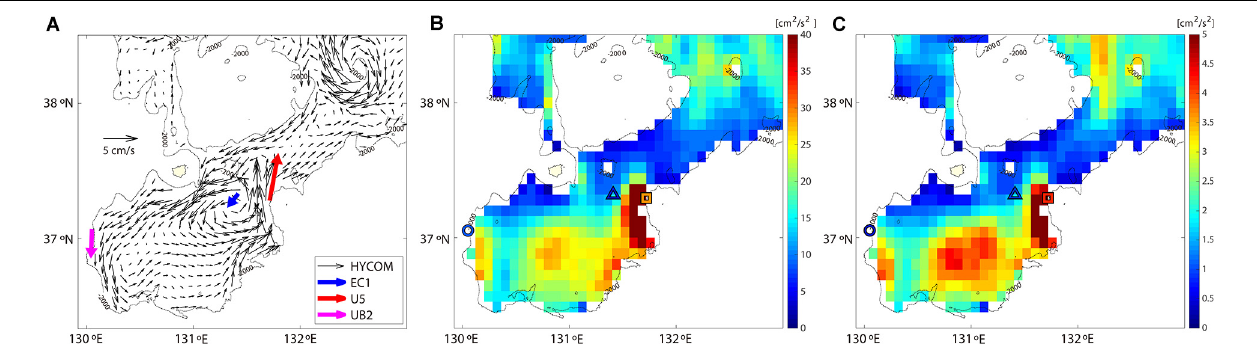
FIGURE 4 | Statistics of deep currents reproduced by HYCOM reanalysis data and moored data. (A) Mean velocity field using HYCOM data and moored data at EC1, U5, and UB2 (black, blue, red, and purple arrows, respectively), and variance of v currents for (B) unfiltered case and (C) longer intraseasonal band. In panels (B,C) , the colors of the symbols for EC1 (triangle), U5 (square), and UB2 (circle) denote the variance of the observed v currents with the same scale shown in the right color bar.